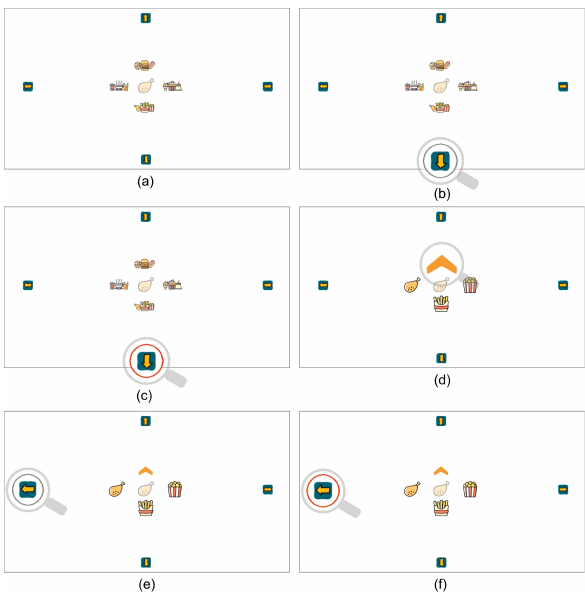
Figure 6. The two-stage item-selection process of choosing an item in GaVe. The user first selects a target cluster and then selects the desired item from the cluster. The gray circle in the figure is the real-time feedback on which item the user is looking at, and the red circle is the feedback about the confirmation of a selection. The semi-transparent item is the given target. The gray magnifying glass marks the detected eye position, which does not appear in real